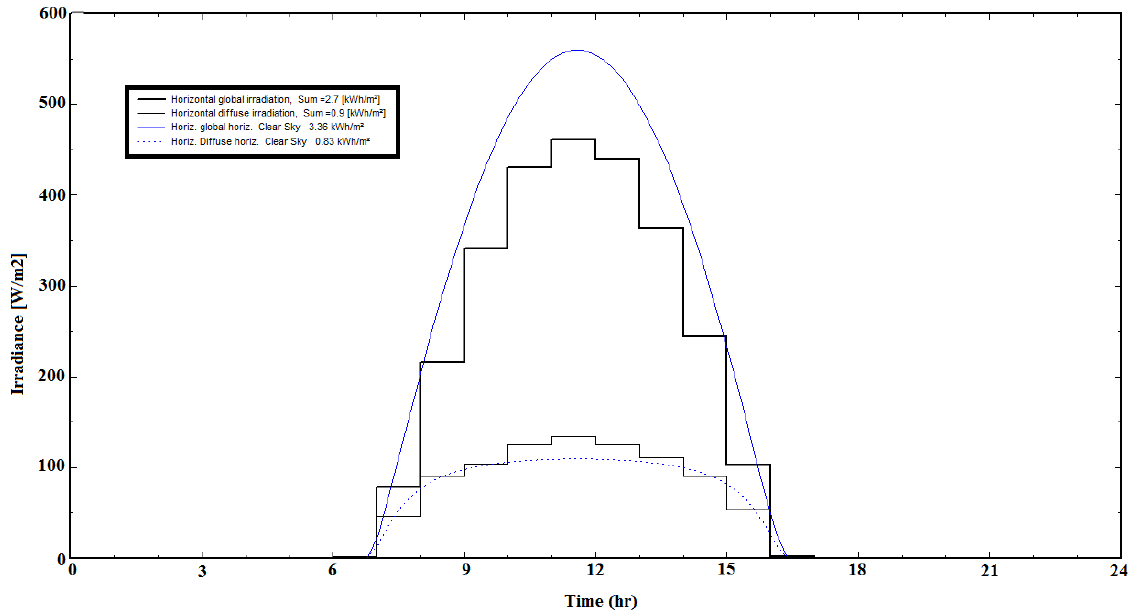
Figure 7. Solar irradiance simulations at different times of day through the PVSyst platform.